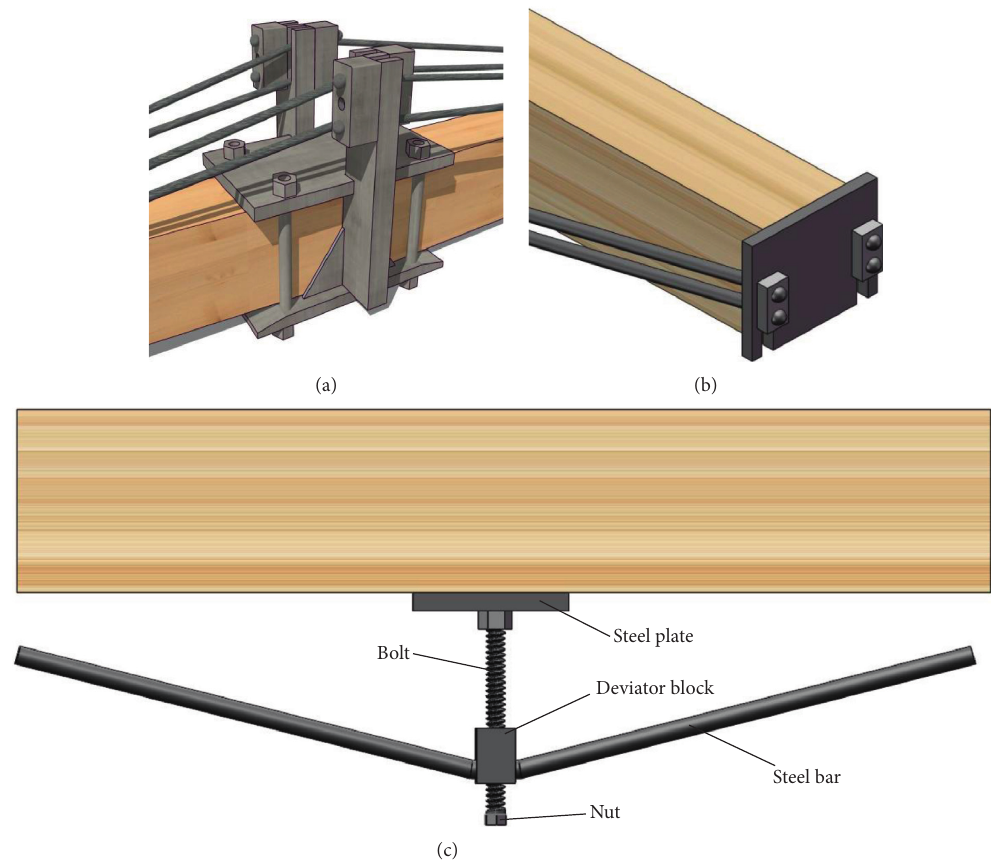
Figure 2: Steel components. (a) Connection apparatus. (b) Steel plate. (c) Prestressed control